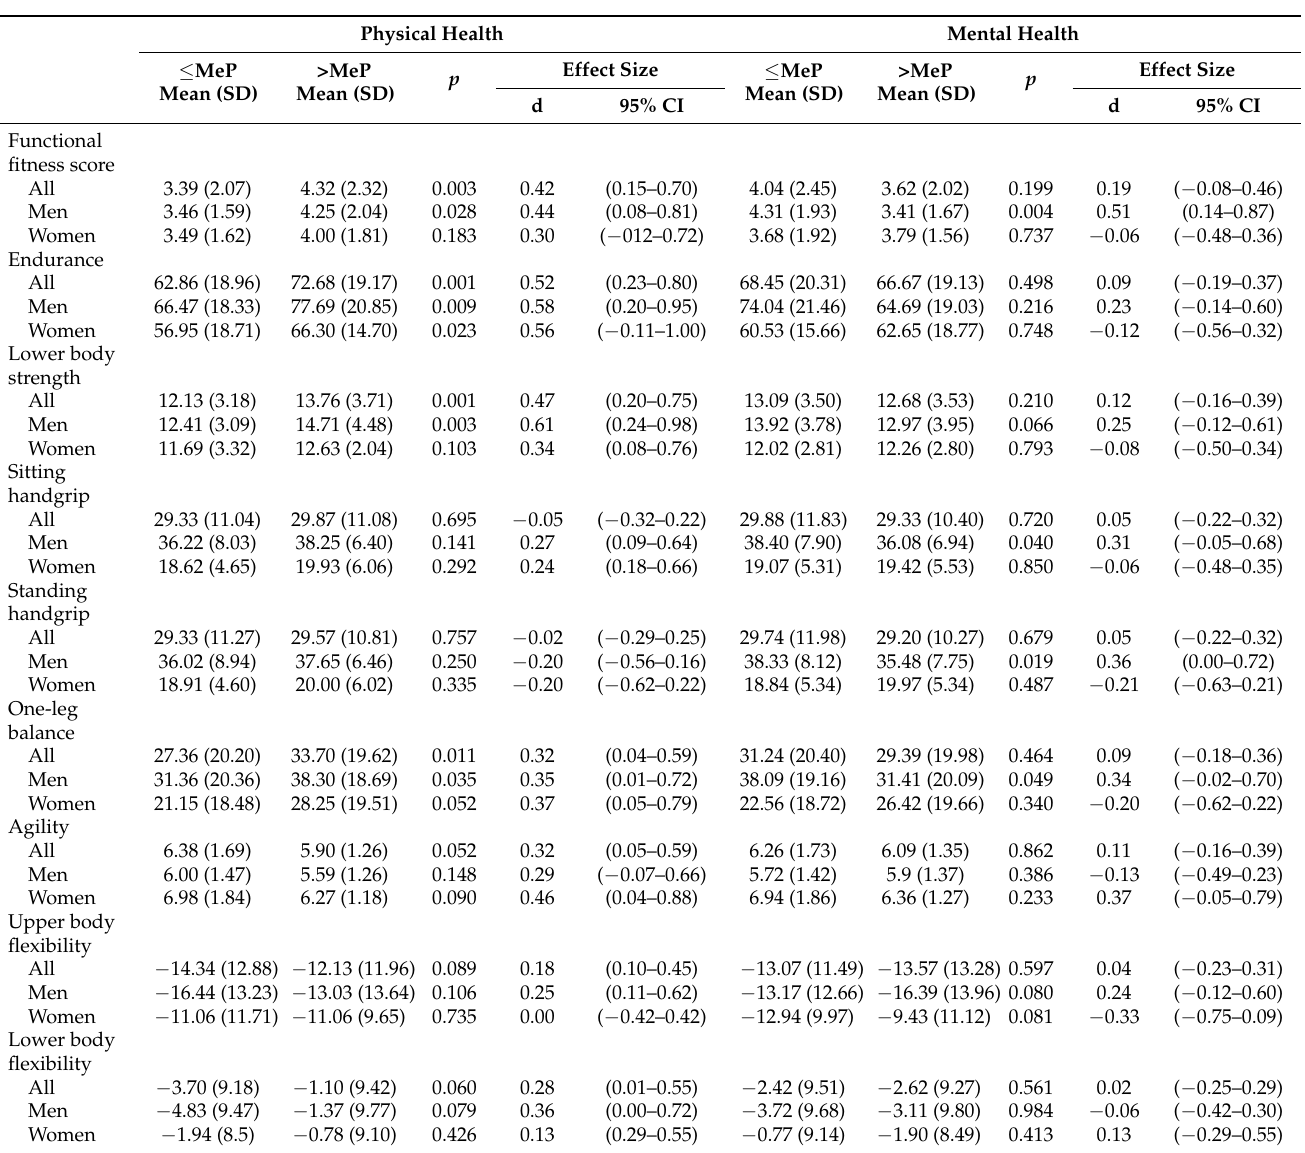
Table 6. Association between physical and mental health vs. physical abilities measured by functional fitness battery